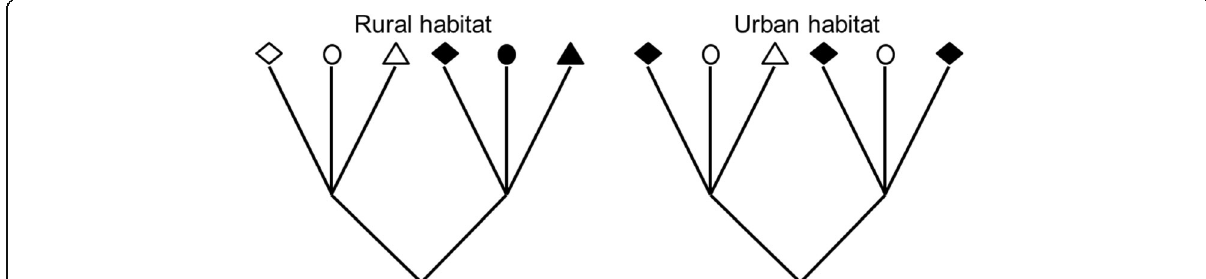
Fig. 3 Summary of the results obtained in the study. Species inhabiting rural areas (black symbols) are phylogenetically clustered, and they are functionally diverse (different symbols). On the other hand, species inhabiting urban areas (black symbols) belong to different clades but have similar traits (same